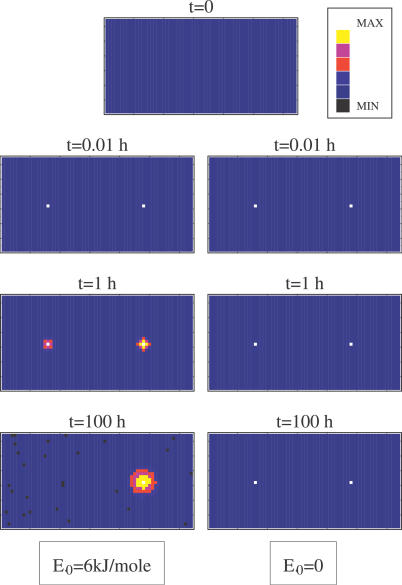
Projection of the Particle Density Distribution on the Plane Orthogonal to the “Chromosomes” at Time t, P(x,y;t), Shown in a Color Scale during a Single Typical Run (Here the System Linear Size Is L = 32d
0 and Molecule Concentration Is c = 0.025)In contrast to the “random walk” case E
0 = 0 (right), if E
0 = 6 kJ/mole (left), particles accumulate after a transient around a single “chromosome” as the region around the other one is depleted.